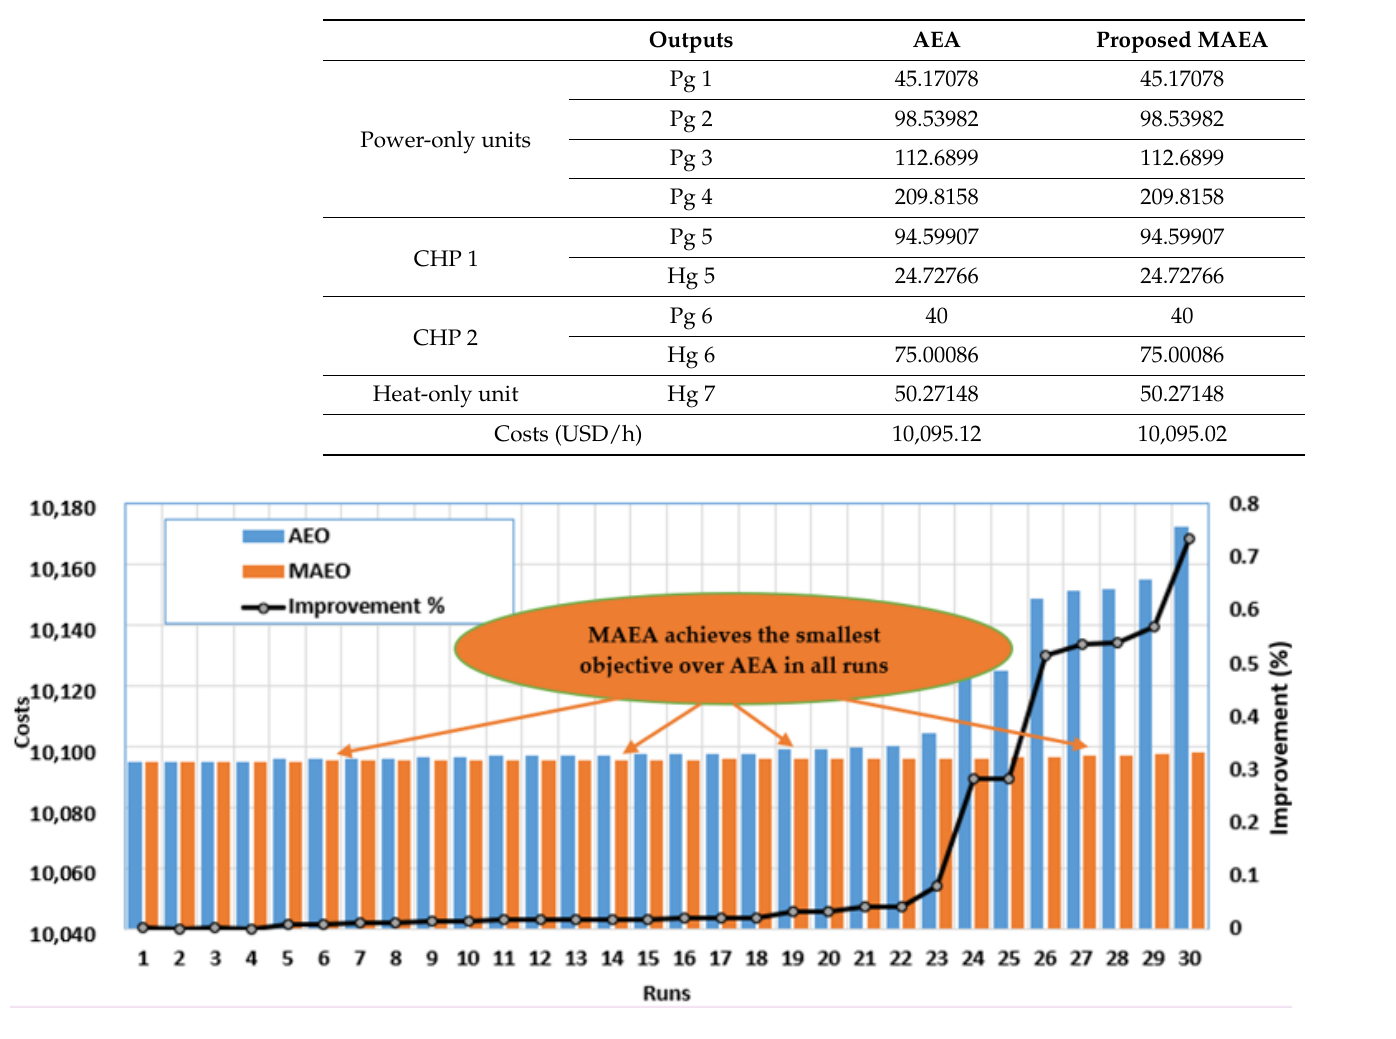
Table 3. Optimal operational settings and related costs of the proposed MAEA and the basic AEA of Case 2.